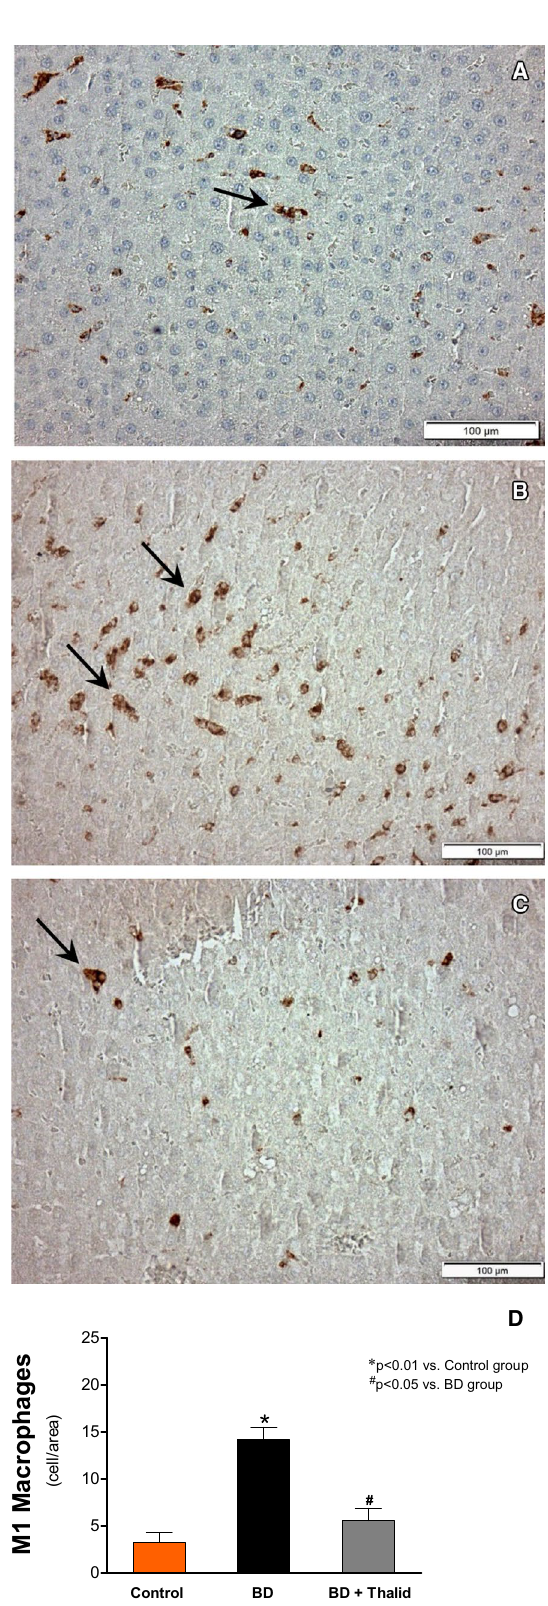
Figure 3. Immunohistochemical detection ( A – C ) (arrow) and comparative analysis ( D ) of M1 macrophages 6 h after brain death in the different groups. Original magnifications: ×